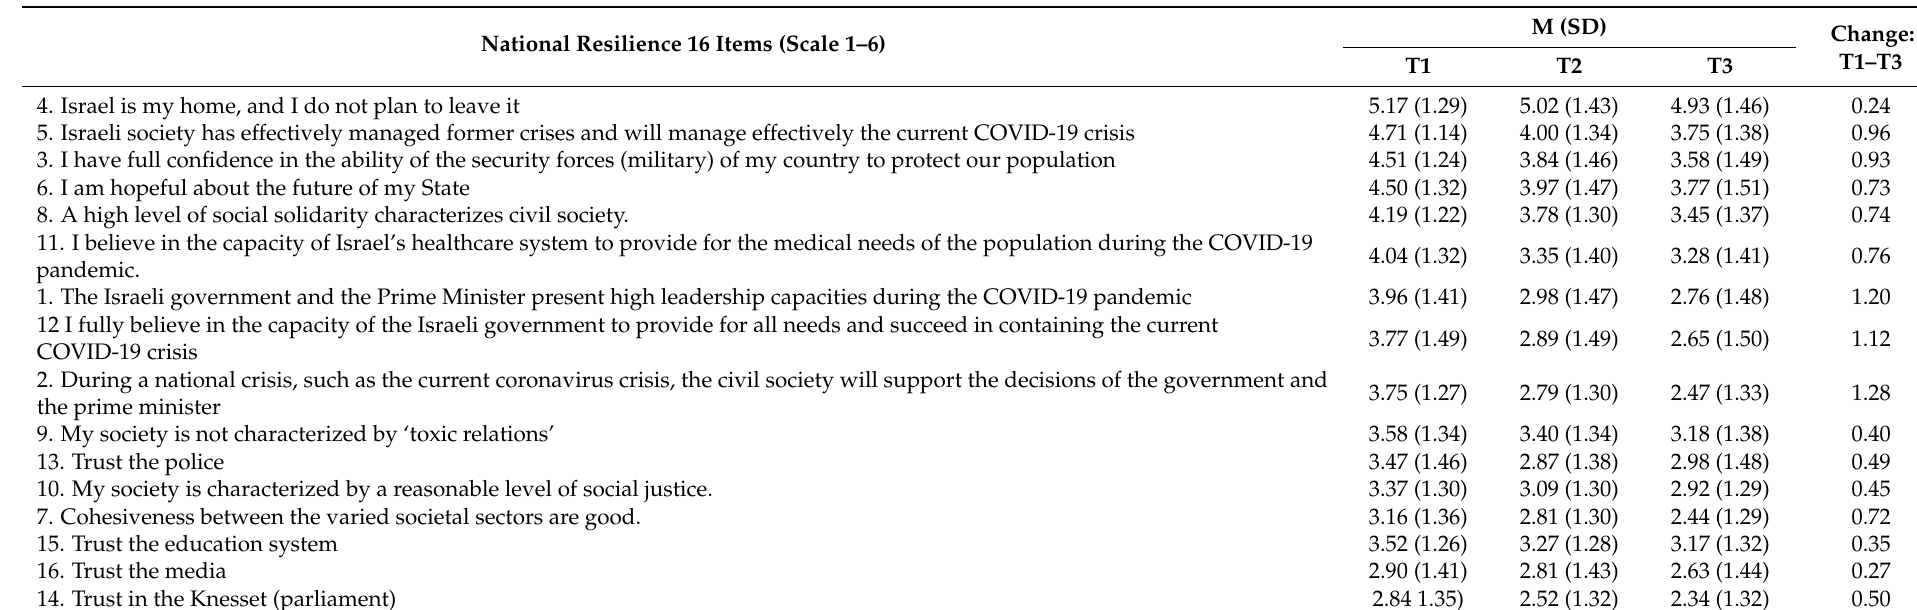
Table 3. Average and standard deviation of NR-16 items, across three repeated measures (arranged from high to low NR